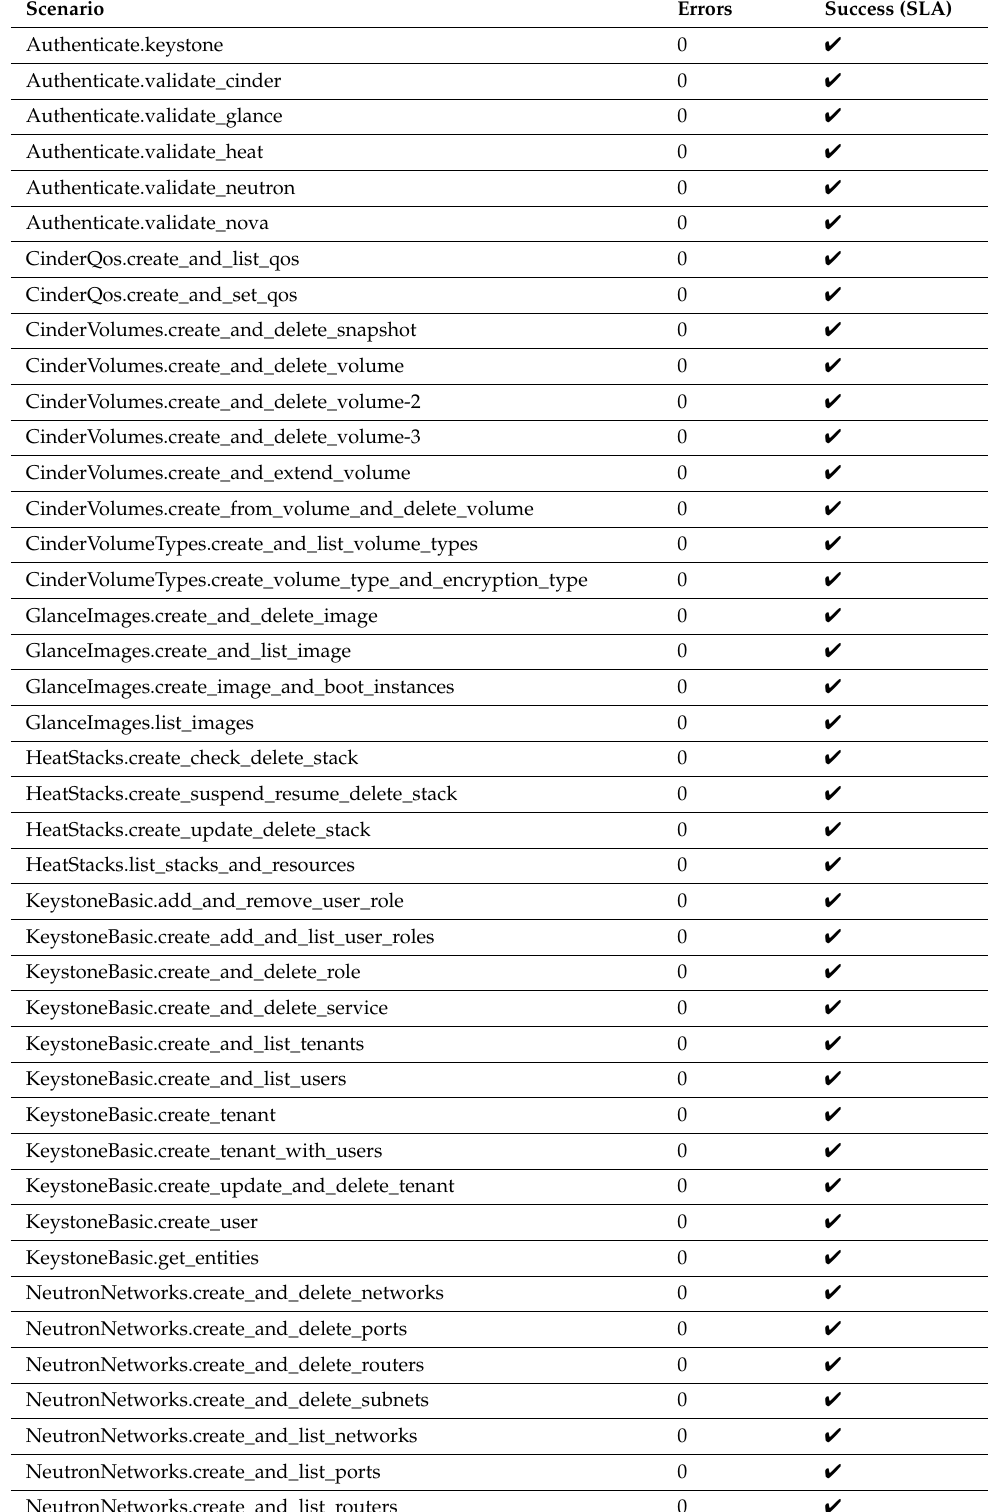
Table A2. Result of